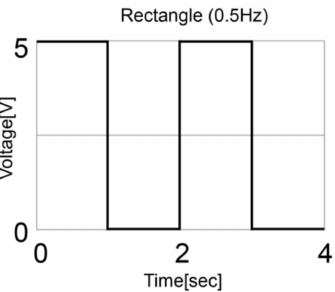
Figure 2. Lighting flash pattern when the robot was listening to a